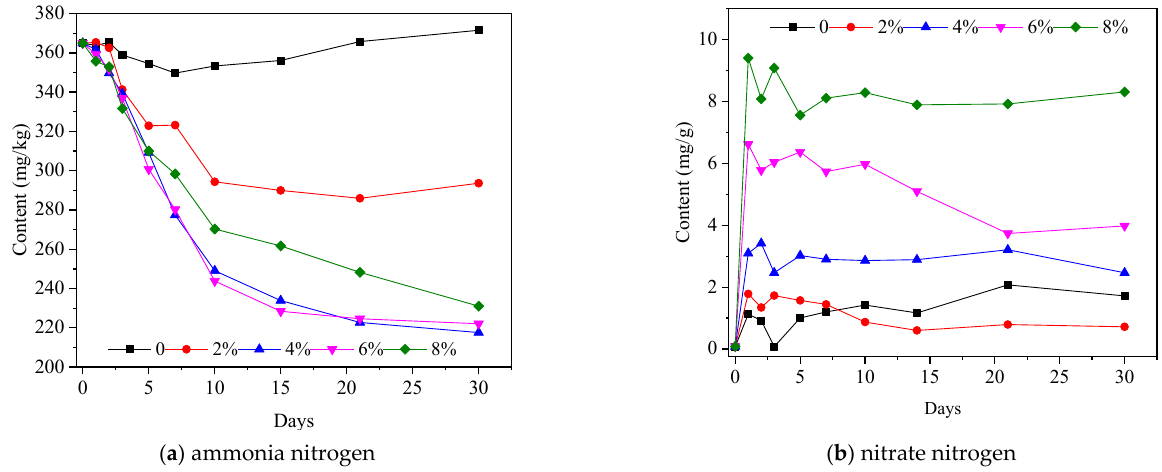
Figure 1. Variation of ammonia nitrogen/nitrate nitrogen content in sediments.